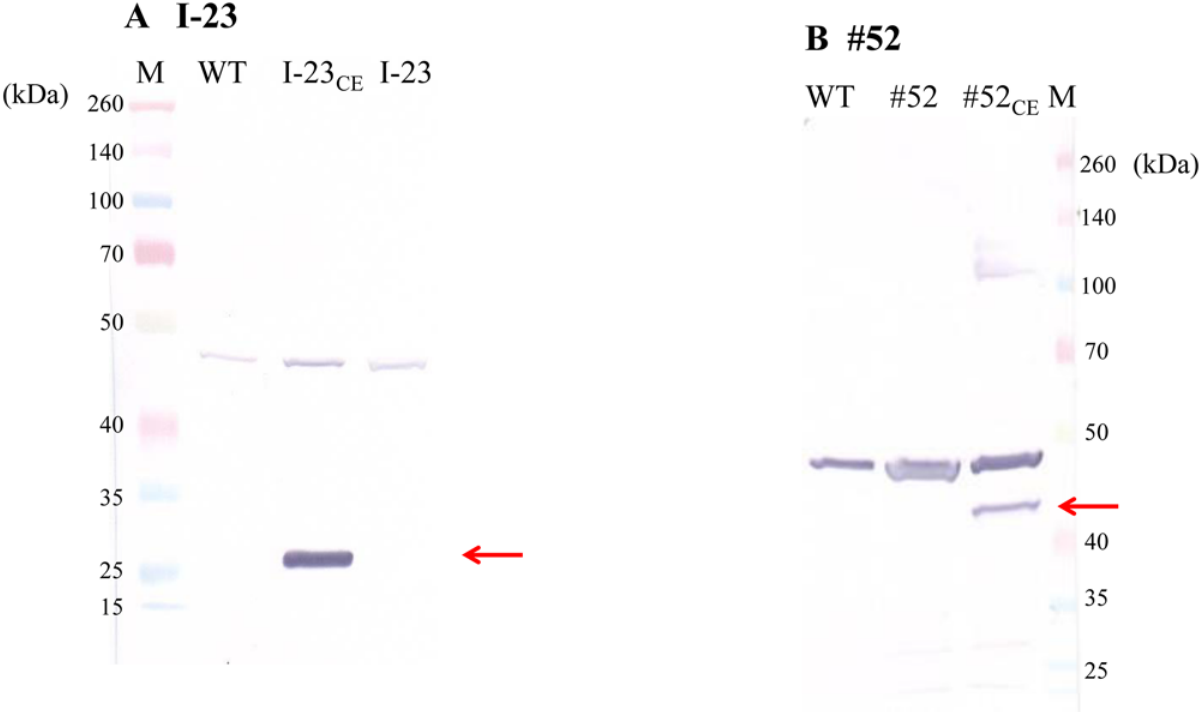
Fig 2. Immunoblotting analysis of production of LDC:FLAG-tag (A) and AlaR:FLAG-tag (B). Total protein (40 μ g) was loaded in each lane of 12% SDS- polyacrylamide gels, and anti-FLAG was used to detect the proteins produced. Arrows indicate LDC:FLAG-tag (A) and AlaR:FLAG-tag (B). M: markers for molecular masses. WT: wild type